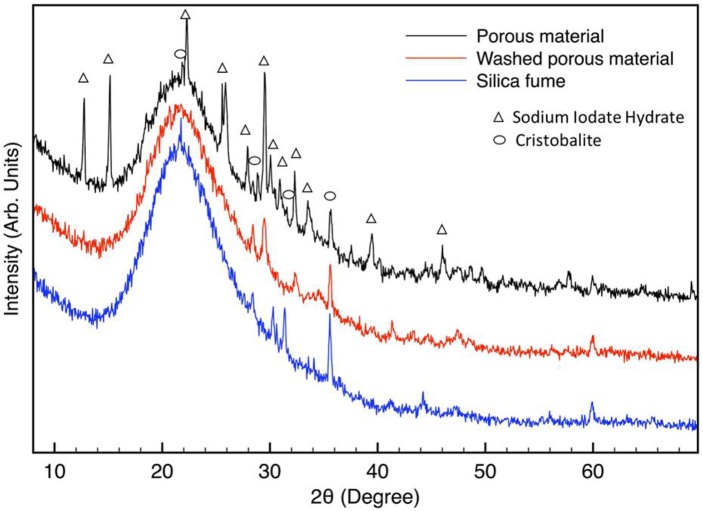
XRD spectra of synthesized porous material before and after washing. XRD pattern of silica is also reported. Sodium iodate hydrate (NaIO3·H2O, PDF CARD n° 321096) and Cristobalite (SiO2, PDF CARD n° 751544 and 010438).